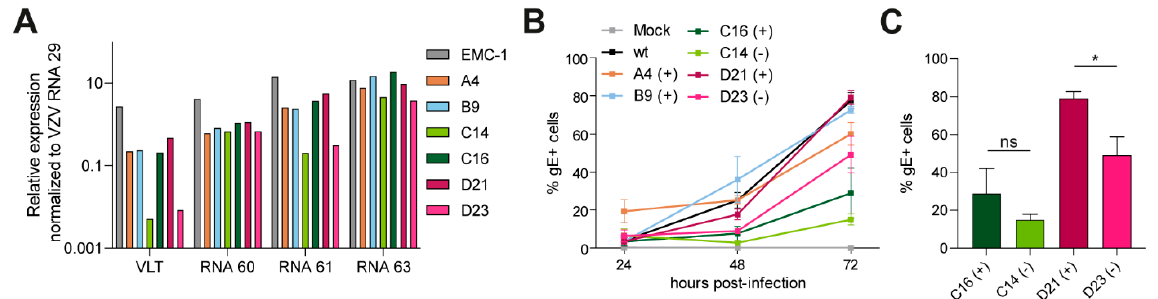
Figure 4. Characterization of VZV VLT mutant viruses generated using combinations of two sgRNAs. ( A ) Relative expression level of VLT RNAs, RNA 60, RNA 61 and RNA 63 in ARPE-19 cells asynchronously infected with either wild-type VZV EMC-1 or mutants A4, B9, C14, C16, D21 and D23. Expression levels were normalized to VZV RNA 29 to compensate for differences in infection. ( B ) Representative growth curves of wild-type virus, one mutant per group and two pVLT/pVLT-ORF63(-) viruses by flow cytometry of VZV infected cells ( n = 2 independent experiments, n = 3 technical replicates). Percentages shown are VZV glycoprotein E (gE)—positive cells at 24, 48 and 72 hpi. None of the mutant viruses significantly differed from wild-type (one-way ANOVA). ( C ) Comparison between two pVLT/pVLT-ORF63(+) viruses (C16 and D21) and their pVLT/pVLT-ORF63(-) counterparts (C14 and D23) at 72 hpi. ns: not significant and * p < 0.05 by unpaired Student’s t -test.